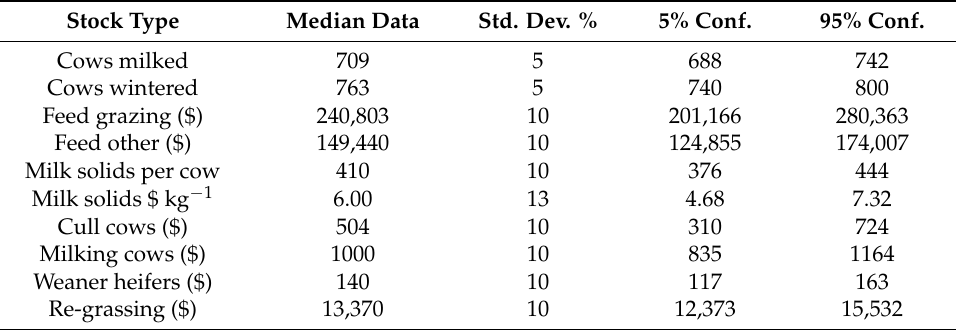
Table 2. Modelling price inputs, correlation to rainfall, and 5–95% confidence levels for a Canterbury dairy farm.